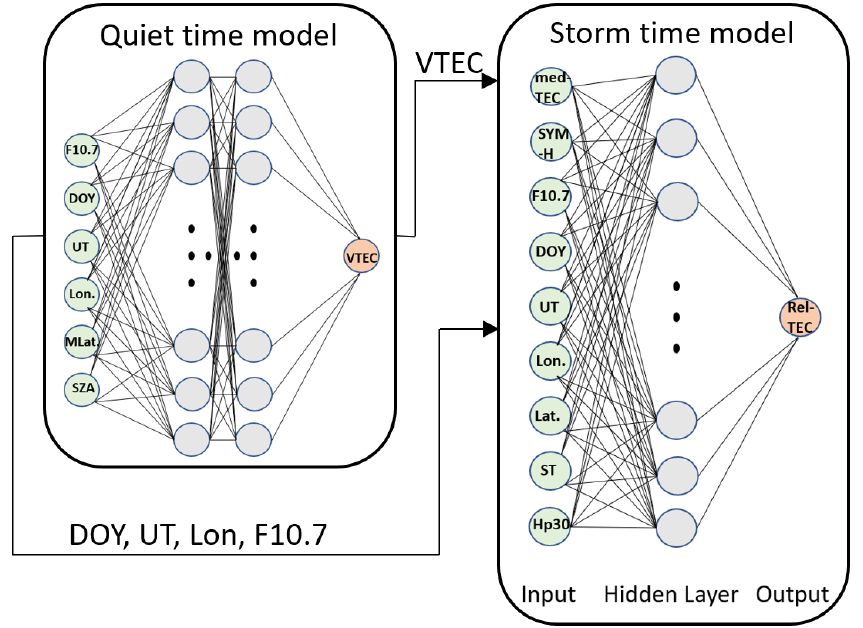
Figure 7. An overview of how the storm-time model is coupled with the quiet-time model. The quiet-time model’s vertical TEC (VTEC) predictions are used as a substitute for the 27-day median